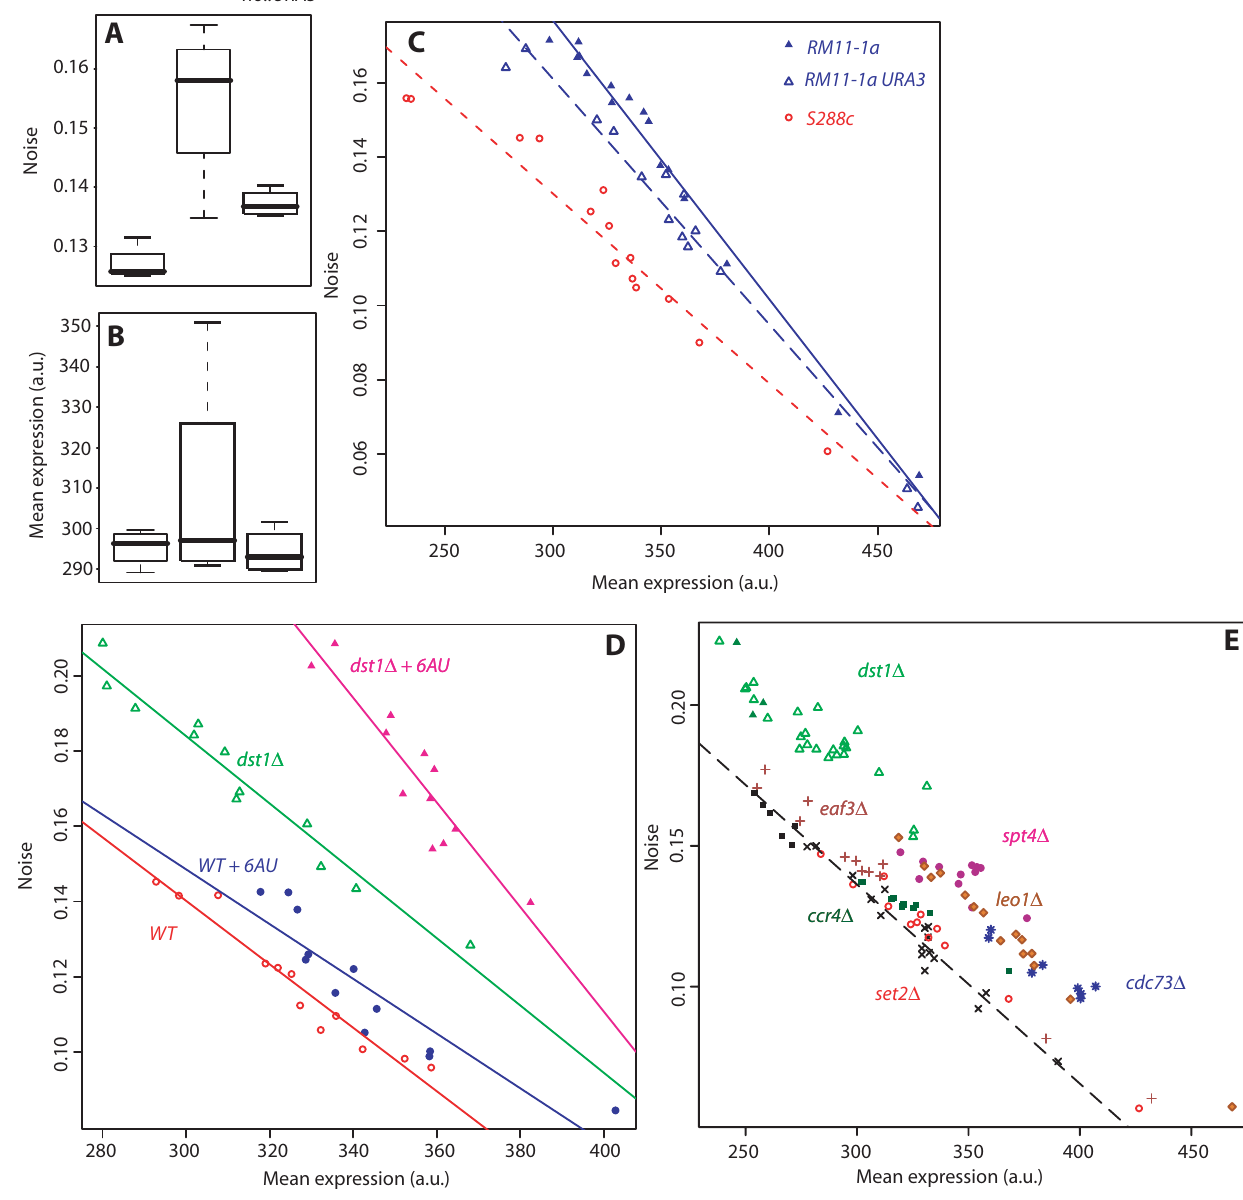
Figure 4. Increased noise resulting from transcriptional elongation impairment. A–B) Comparison of P MET17 -GFP noise and mean expression levels between S288c-derived strains GY244, GY246 and GY333 that were isogenic except for the specified ura3 genotypes. C) Complementation of ura3 in RM11-1a derived strain partially reduced its high-noise phenotype. Strains GY51 (open red circles), GY53 (filled blue triangles) and GY601 (open blue triangles) were compared at various induction strength (Methionine concentration from 0 to 200 m M). Each dot represents one sample of 15,000 cells. Lines indicate linear fits on each strain. D) Additive noise increase in response to 6-azauracil (6AU) and TF II S ( dst1 ) mutation. Wild-type strain GY51 (circles) and dst1 D strain GY321 (triangles) were cultured with (filled blue, filled magenta) or without (open red, open green) 6AU, at various induction strength as in c). Lines indicate linear fits on each subgroup. E) Comparison of P MET17 -GFP noise and mean expression levels between various transcription elongation mutants. Strains GY602 (control strain trp1 D ::KanMX , black ‘x’), GY321 ( dst1 D ::hisG , open green triangles), GY358 ( dst1 D ::hisG ho D ::KanMX , filled green triangles), GY361 ( dst1 D ::hisG ho D ::(DST1 + KanMX) , filled black squares), GY603 ( eaf3 D ::KanMX , brown ‘ + ’); GY604 ( spt4 D ::KanMX , purple filled circles), GY605 ( leo1 D ::KanMX , orange filled diamonds), GY606 ( set2 D ::KanMX , open red circles), GY607 ( ccr4 D ::KanMX , filled dark green squares), GY608 ( cdc73 D ::KanMX , blue stars), that were all isogenic to GY51 except for the specified genotypes were compared at various induction strength. Dashed line represents linear fit to the GY602 control strain data points (no elongation impairment). detectable difference in mean expression (Figure 4D). This locus (Figure 4E). Even higher noise levels were obtained when dst1 D cells were treated with 6-azauracil (Figure 4D), highlighting increase was suppressed when the mutation was complemented by integrating the wild-type DST1 (YGL043W) gene at the HO the gradual noise increase with gradual transcriptional elongation